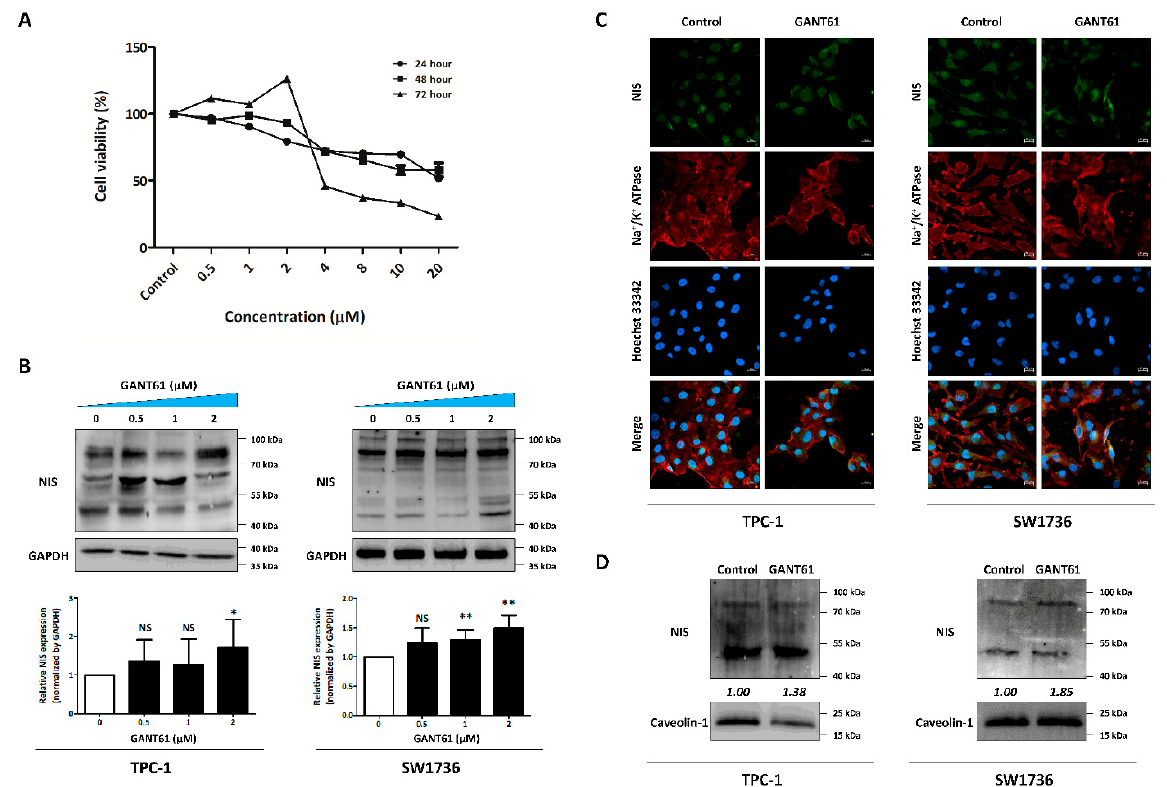
Figure 5. Efficacy of GANT61 in restoring endogenous NIS expression in thyroid cancer cells. Both TPC-1 and SW1736 cells were exposed to GANT61. ( A ) Results of cell viability assay showing time- and dose-dependent effects of GANT61 in TPC-1 cells. Mean ± SD values from three optical density (OD) is reported. ( B ) Endogenous NIS expression in whole cell lysate after treatment with GANT61. GAPDH was used as a loading control. The results are expressed as mean ± SD values of the experiment performed in quintuplicates. * p < 0.05, ** p < 0.01, NS: Not Significant (by Student’s t -test). ( C ) Immunofluorescence images for monitoring changes of expression and localization with endogenous NIS in thyroid cancer-derived cells treated with GANT61. ( D ) Change of endogenous NIS expression in plasma membrane proteins. Caveolin-1 were used as loading controls for plasma membrane proteins. Raw data is presented in Figures S15 and S16.